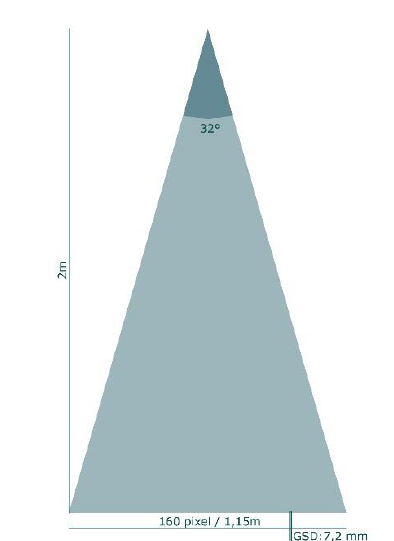
Figure 10. GSD of the IR camera at 2m distance from the object For IR images the GSD parameter by itself cannot provide a complete overview of the image metric and informative